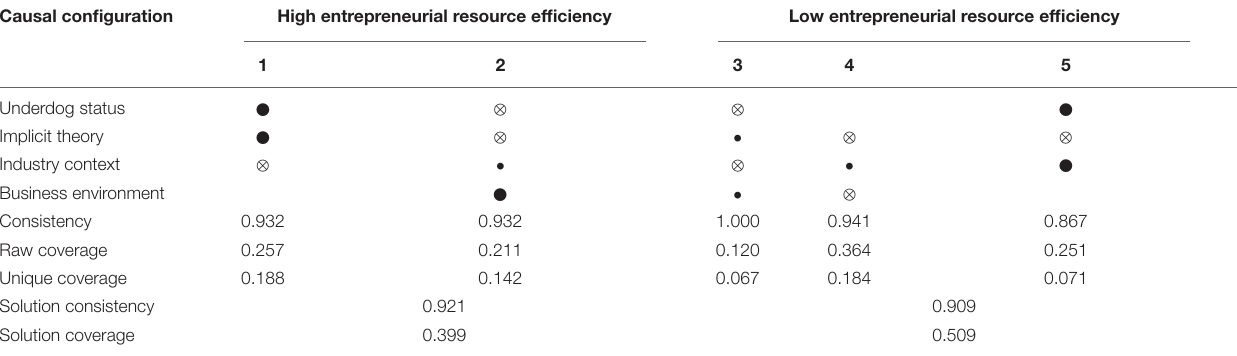
TABLE 8 | Conditional configuration sufficiency analysis. Causal